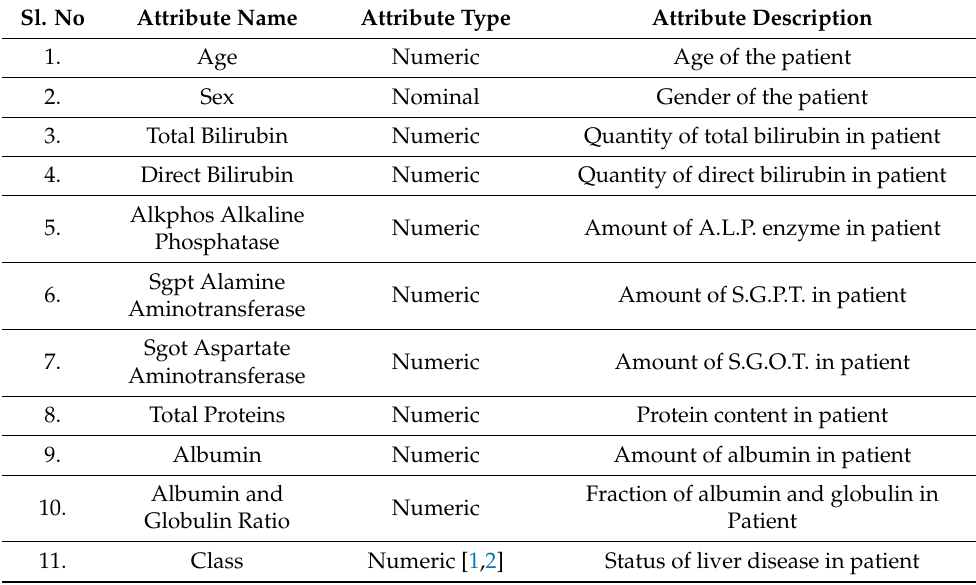
Table 1. Description of Liver patient